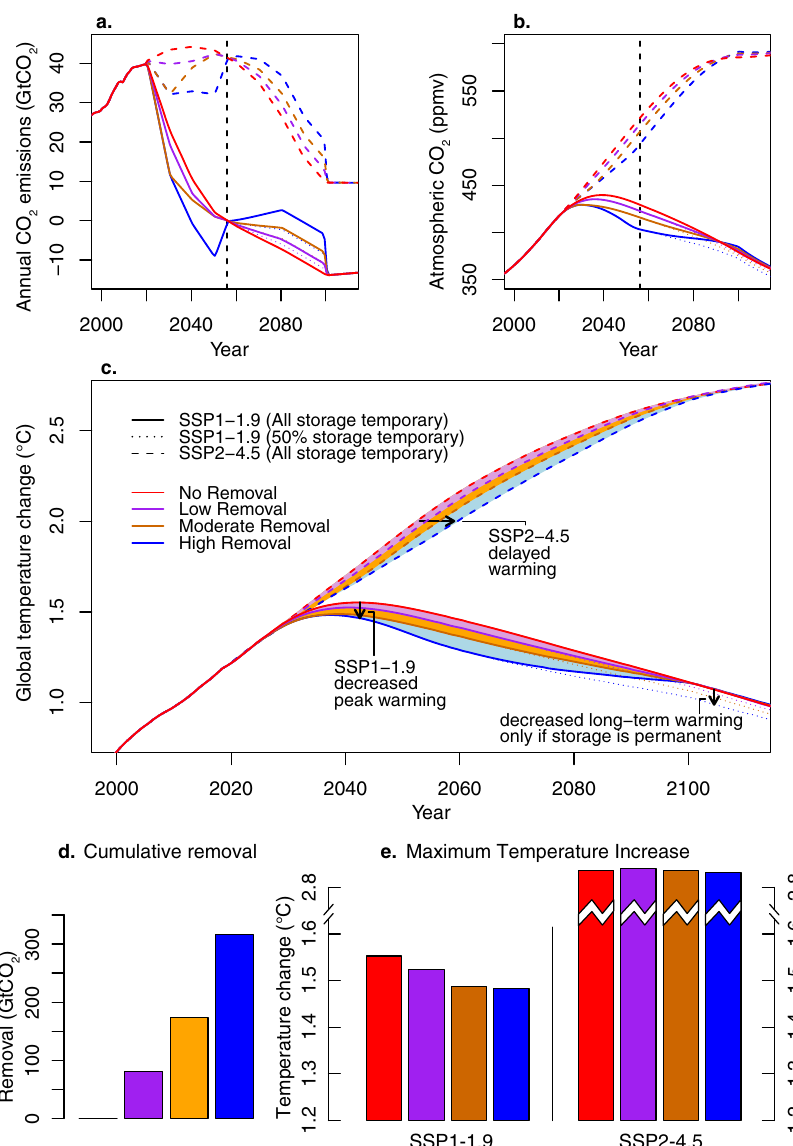
Fig. 1 Climate response to prescribed temporary carbon removal scenarios. a , d Prescribed CO 2 removal and subsequent full or partial (50%) return to the atmosphere resulted in cumulative temporary removals of 81 (purple lines/bars), 173 (orange lines/bars), and 316 (blue lines/bars) GtCO 2 relative to the baseline scenarios (red lines/bars). b Atmospheric CO 2 decreased by maximum amounts of 7 to 28 ppm across scenarios in response to the prescribed removal. c , e Global temperatures decreased by a maximum amount of 0.04 to 0.17, relative to the baseline SSP scenarios, and in the SSP1- 1.9 scenario peak temperatures decreased by between 0.03 and 0.07 °C. The effect on long-term temperature in the SSP1-1.9 scenario depended on the longevity of the stored carbon: fully temporary storage (solid lines in panels a – c ) caused temperatures to return to the baseline scenario temperature by the end of the century, whereas if 50% of the stored carbon was assumed to be stored permanently (dotted lines), the effect on global temperature was similarly